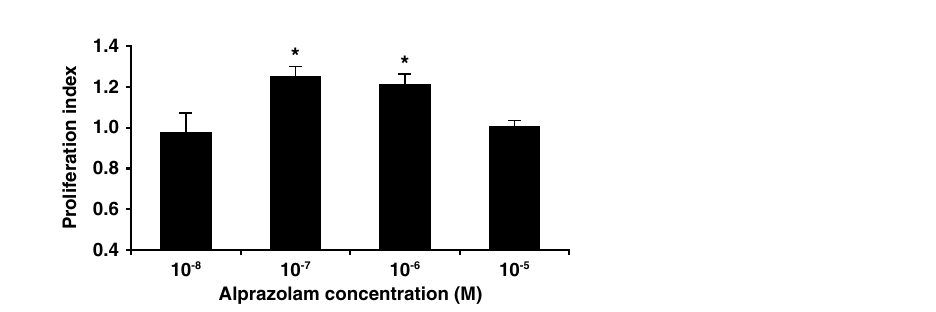
Figure 2. ( A ) GAD enzymatic activity in INS-1 cells. The GAD enzymatic activity within homogenates was assessed using a standard CO 2 trapping assay as described in Methods. Data shown are mean CPM + / − SEM from a representative assay from three experiments. ( B ) Effect of PAMs on INS-1 cell proliferation. INS-1 cells were cultured with the indicated PAM at a dose range of 10 − 9 to 10 − 6 M and assessed for their proliferation. Data shown are the average rate of proliferation relative to that of cultures with media alone (designated as 1). INS-1 cells were treated with alprazolam ( C ), midazolam ( D ), clonazepam ( E ), or AP-3 ( F ) at the indicated concentrations along with a dose range of GABA. Control cultures were incubated with GABA alone at the indicated concentration (solid lines). †††† p < 0.001 versus control cultures with medium alone. * p < 0.05, ** p < 0.01, *** p < 0.001 versus cultures with the same dose of GABA, determined by Student T test. G) INS-1 cells were cultured with GABA (0.3 mM) and midazolam or clonazepam (100 nM) with, or without, the TSPO inhibitor PK11195 (1 µ M) for 48 hrs.